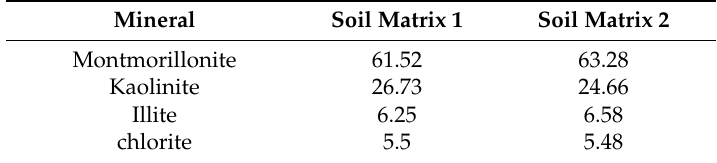
Table1. Basic physical and mechanical properties of the used soil matrix and rock blocks for bimsoil samples. Table 2. Mineralogical composition of soil sample obtained from XRD (X-ray